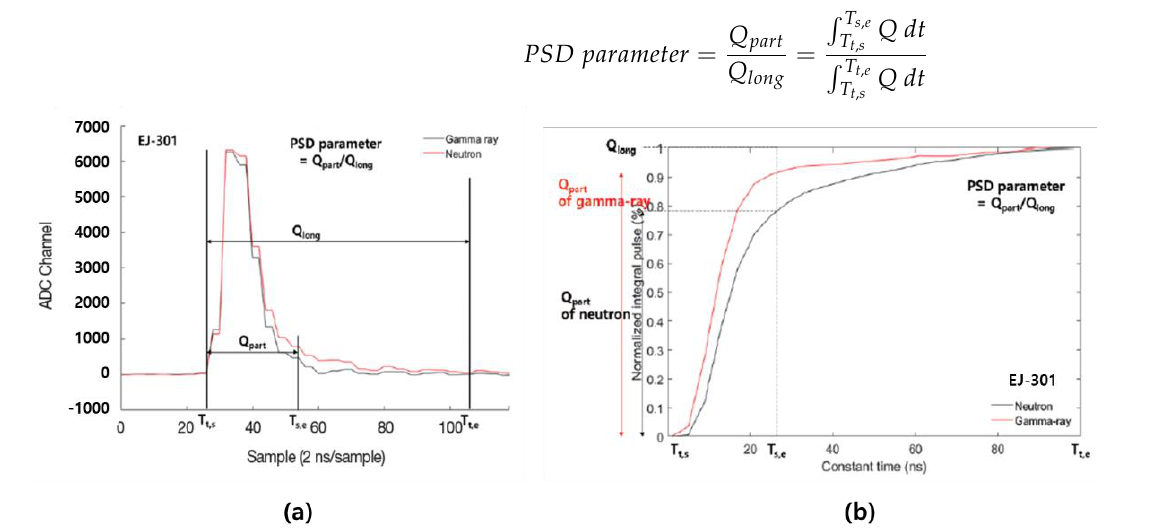
Figure 16. Neutron and gamma signals from the EJ-301 scintillator: ( a ) Signal from digitizer; ( b ) Normalized pulse signal [46].